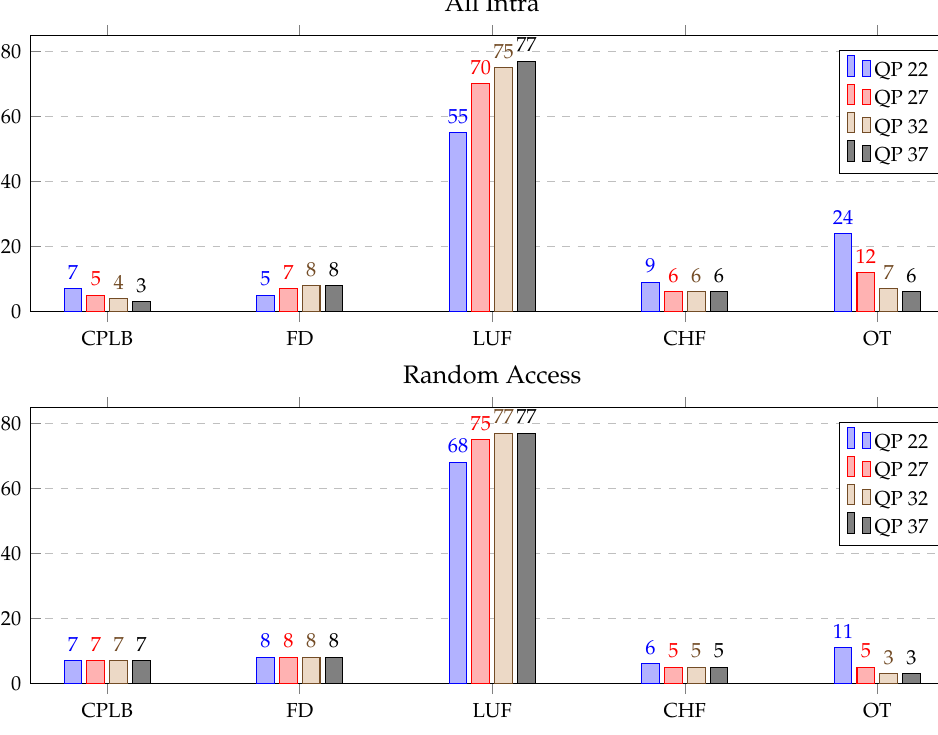
Figure 10. Average time distribution for different parts of the deblocking filter (in %) over the EGPP. revealed that the LCF, CHCF and DeC functions consumed approximately 90% of the 352